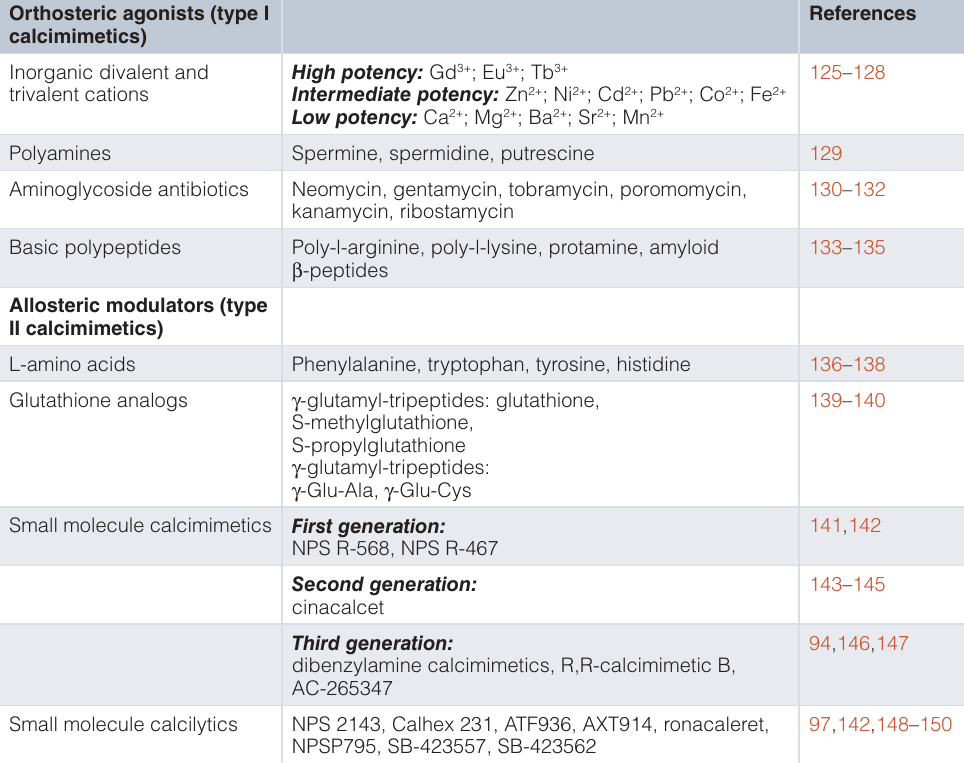
Table 1. Principal orthosteric agonists and allosteric modulators of the calcium-sensing receptor. Orthosteric agonists (type I